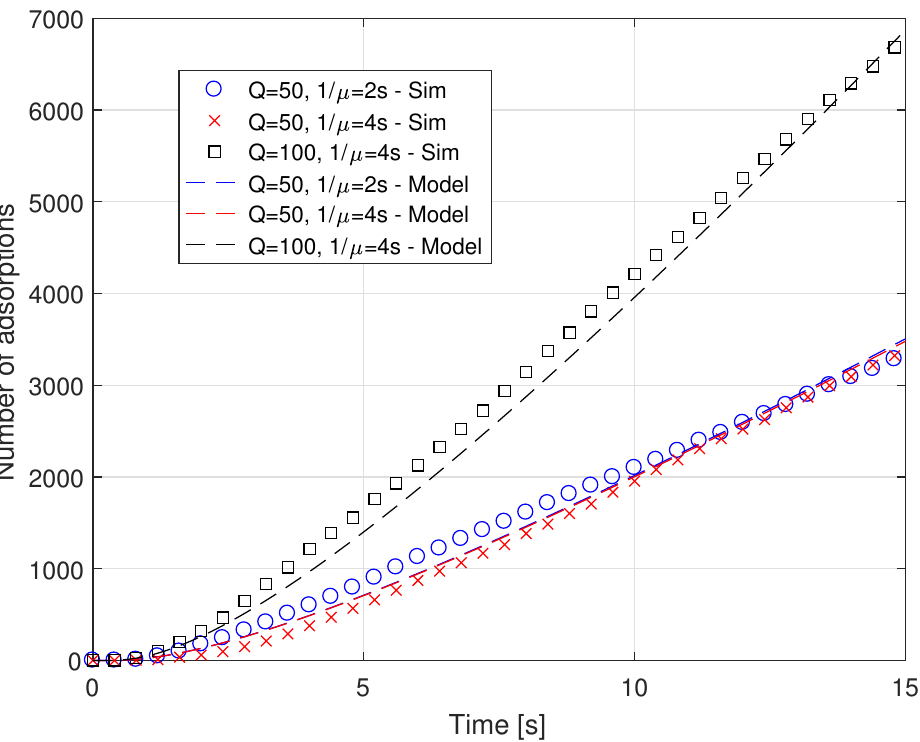
Figure 2. Absorbed molecules vs. time for different values of system parameters (burst size Q and absorption time 1/ µ .